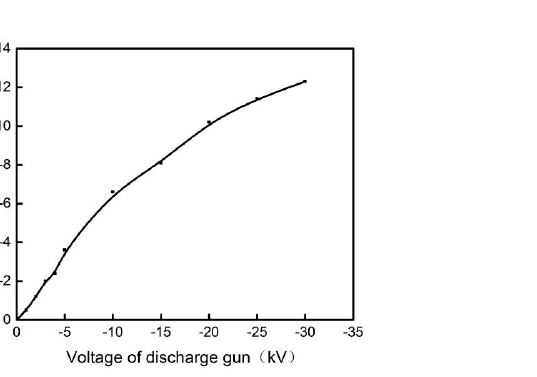
Figure 5. Variation trend of peak value of ESD field with discharge gun voltages.